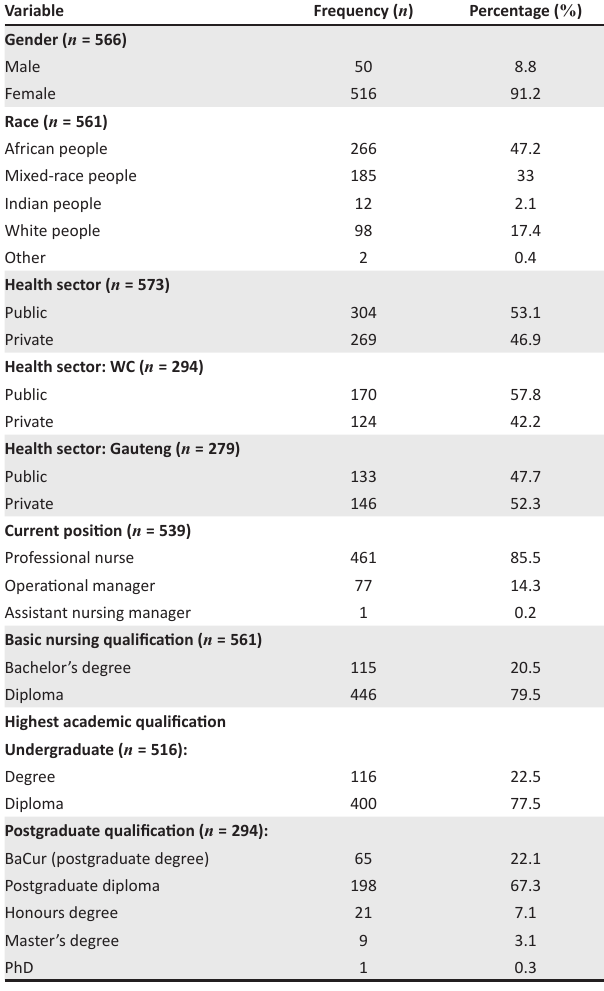
TABLE 1: Demographic data.